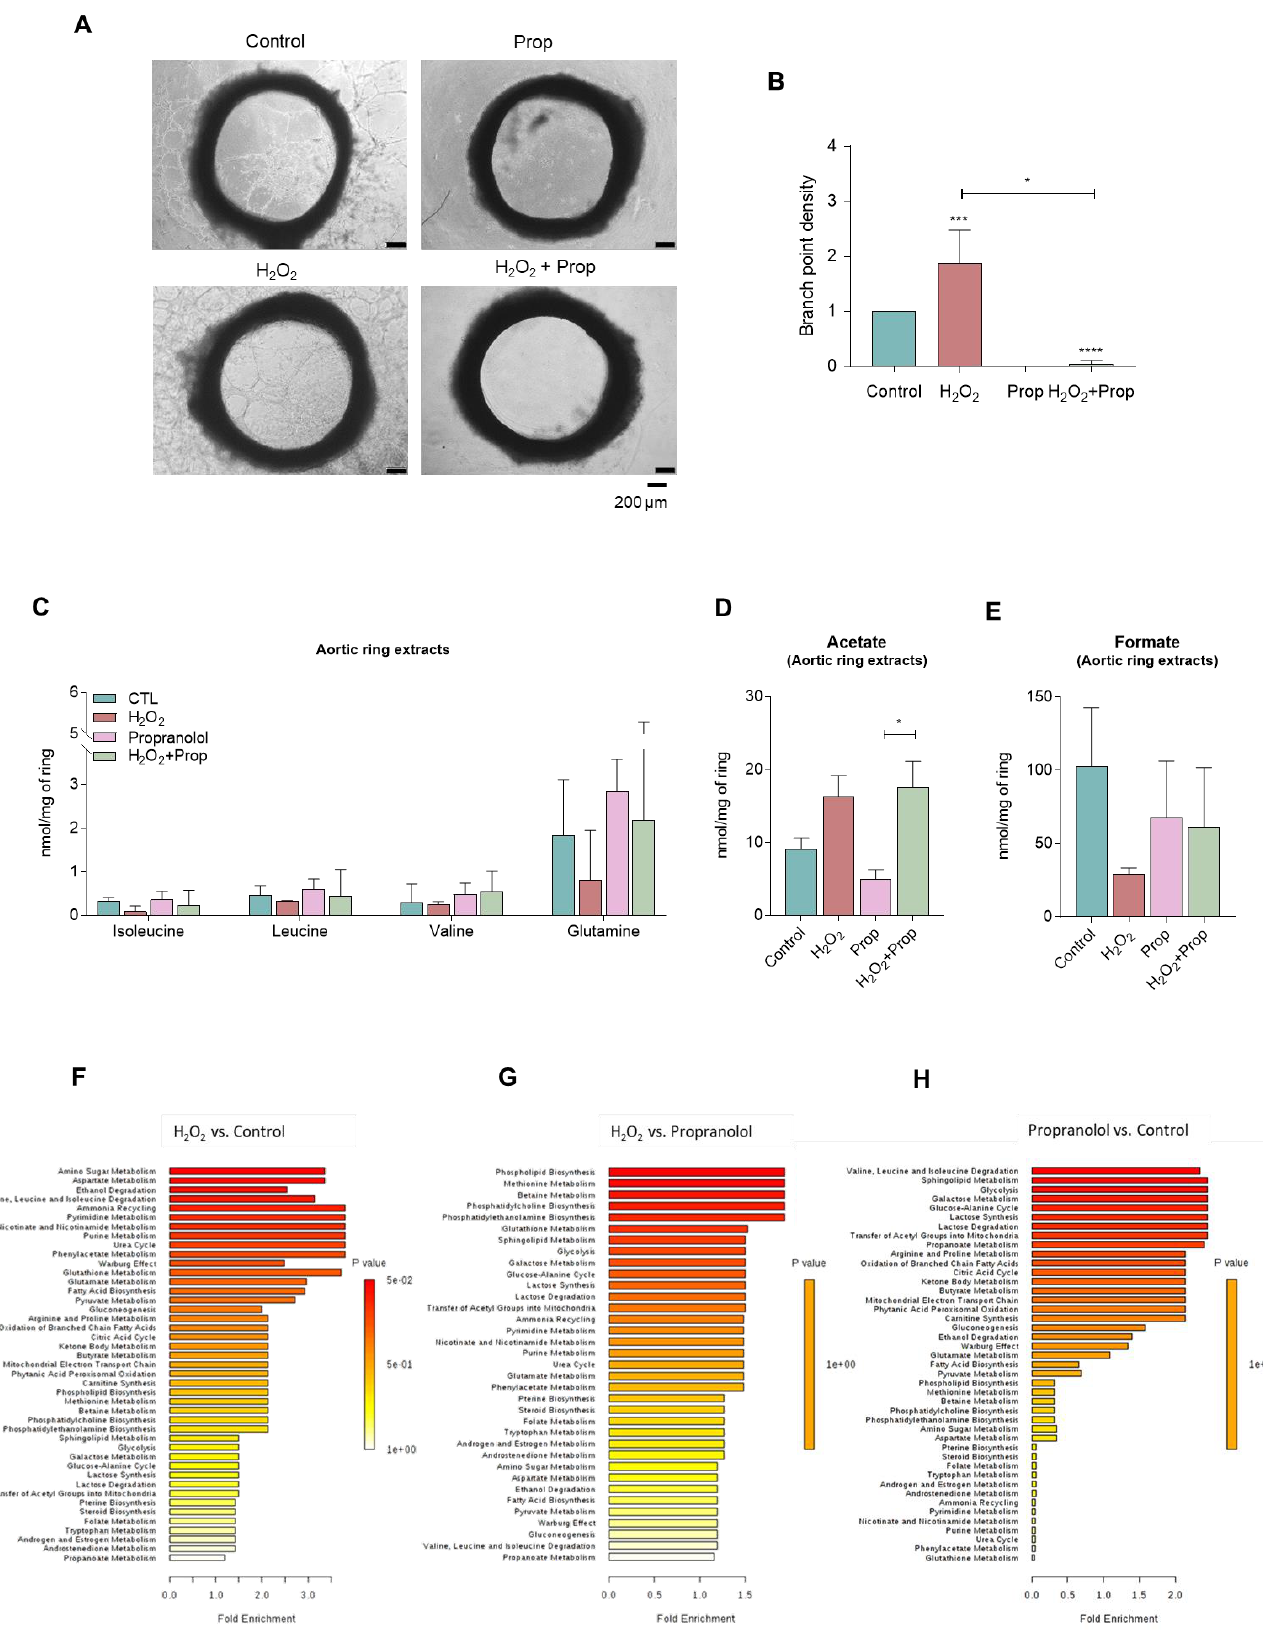
Figure 6. Propranolol inhibits the sprouting of aortic rings . Sections of rat aortic rings were plated in Matrigel and cultured in basal culture condition (control) and with hydrogen peroxide (15 μM, H 2 O 2 ; ROS) in the presence or absence of propranolol (100 μM Prop). Aortic rings’ endo thelial cell